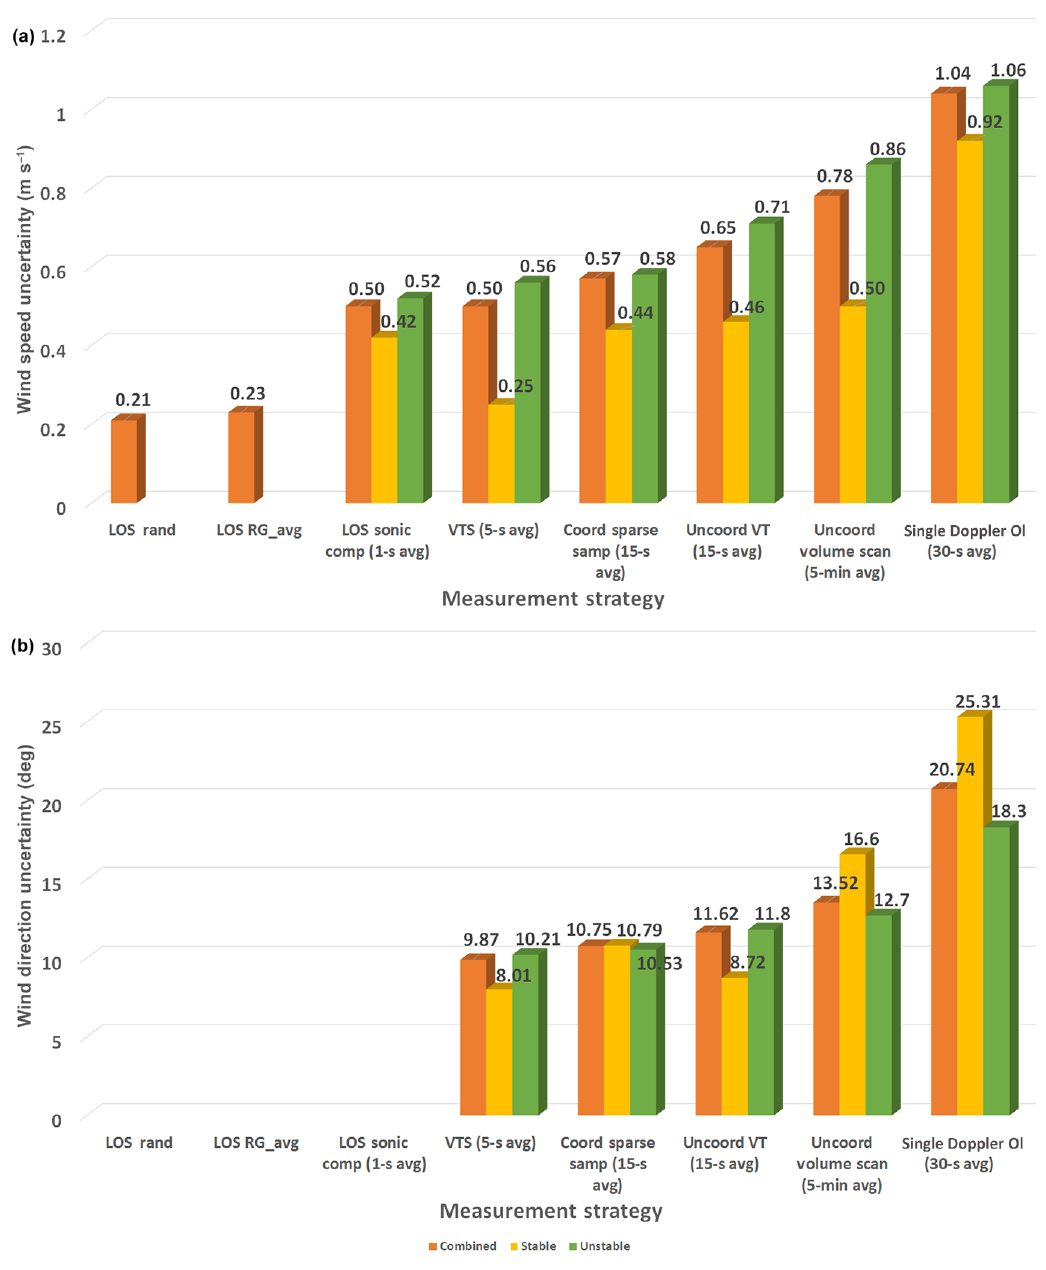
Figure 15. Measurement uncertainty as a function of stability for (a) horizontal wind speed and (b) horizontal wind